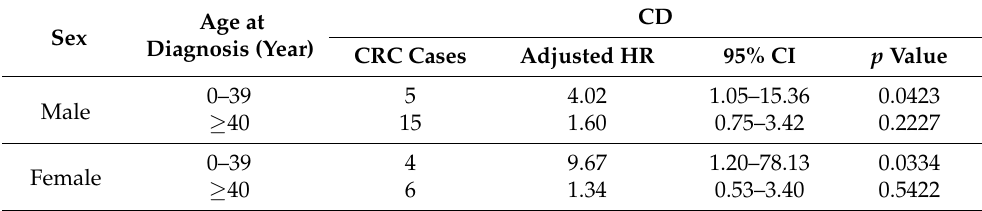
Figure 2. Comparison of incidence rate and HR of CRC between CD and non-CD groups based on age. HR, hazard ratio; CD, Crohn’s disease; CRC, colorectal cancer. Among the men in the CD group, the HR of the 0–39 age group was 4.02 (95% CI, 1.05–15.36) and that of the ≥40 age group was 1.60 (95% CI, 0.75–3.42). For women in the CD group, the HR of the 0–39 age group was 9.67 (95% CI, 1.20–78.13) and that of the ≥40 age group was 1.34 (95% CI, 0.53–3.40) (Table 4). Table 4. Hazard ratio of CD for CRC by sex and age.